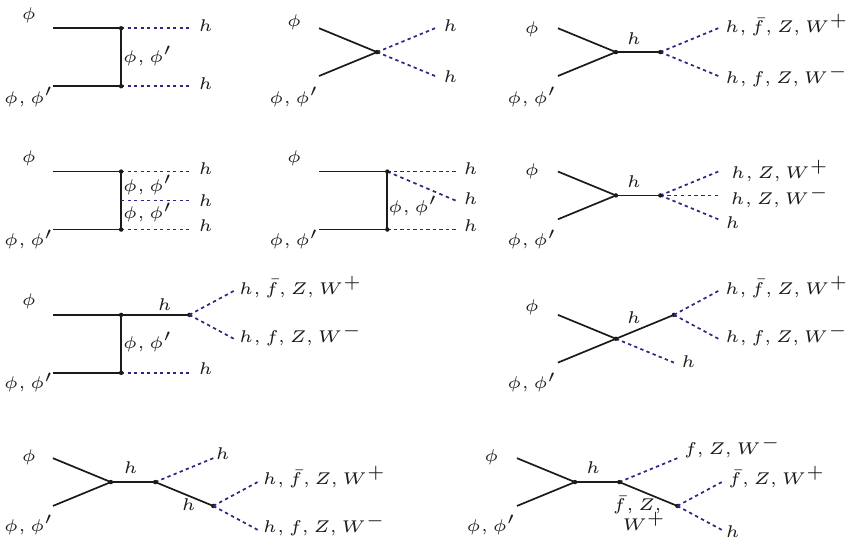
Figure 1 . Annihilation and coannihilation Feynman diagrams are shown up to three particles in the (cid:12)nal state for model in section